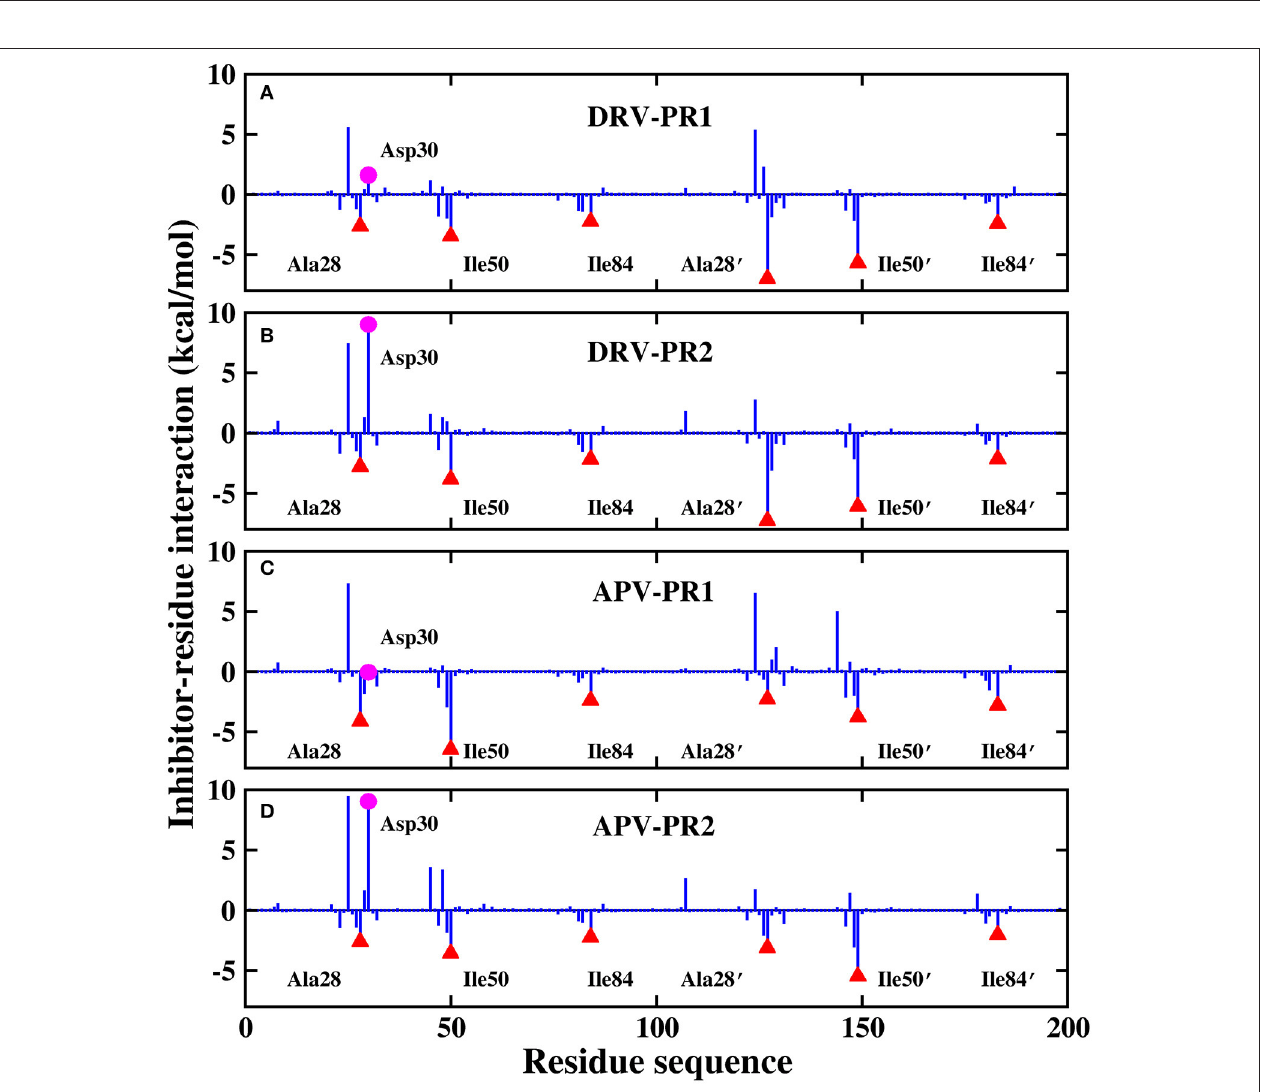
Frontiers in Chemistry |